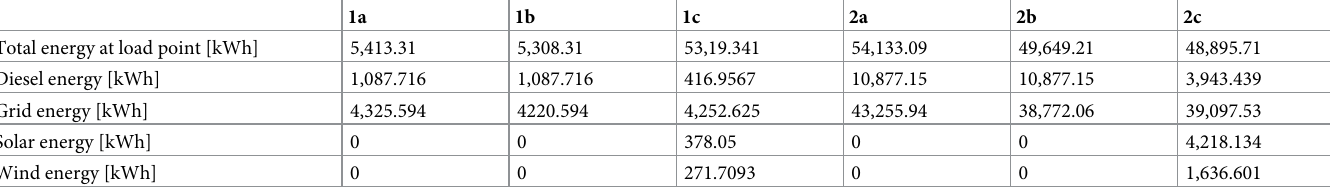
Table 9. Energy supply under various cases.